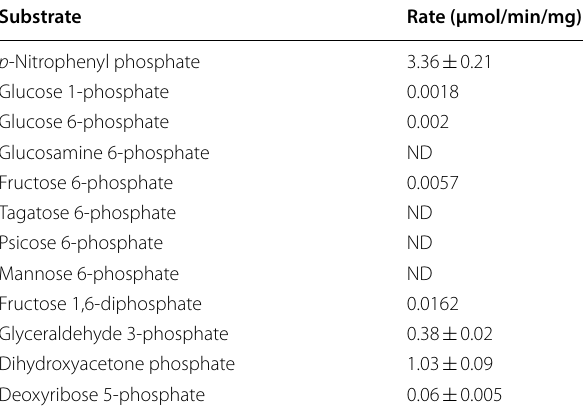
Values were measured at 60 °C in 100 mM HEPES buffer (pH 7.0), containing 10 mM substrate and 5 mM MgCl 2 ND not detected (less than 0.001)